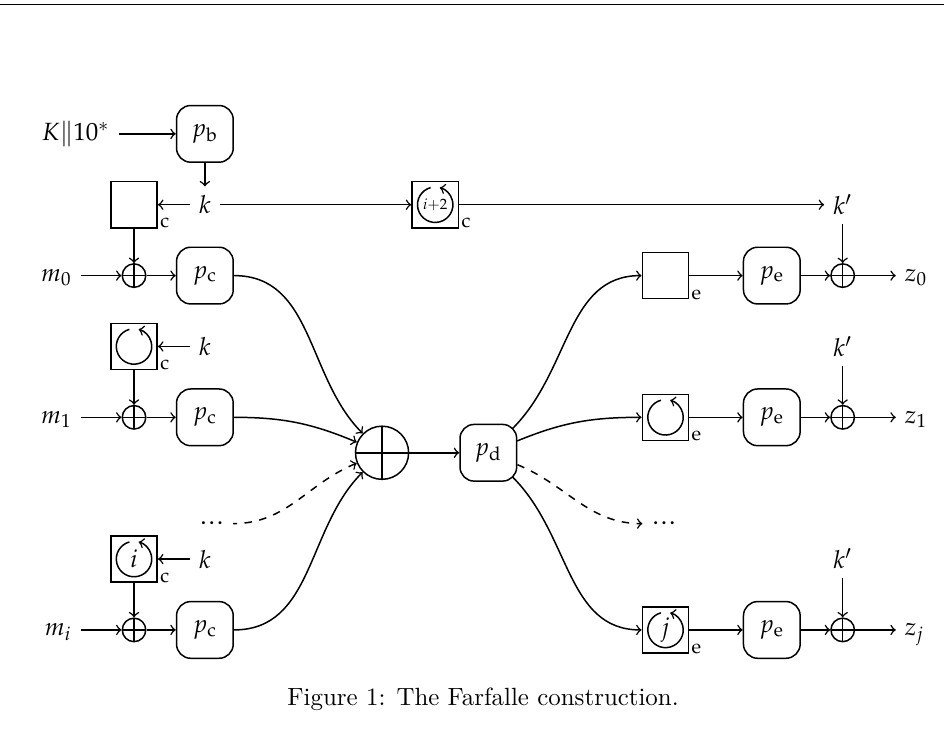
Figure 1: The Farfalle